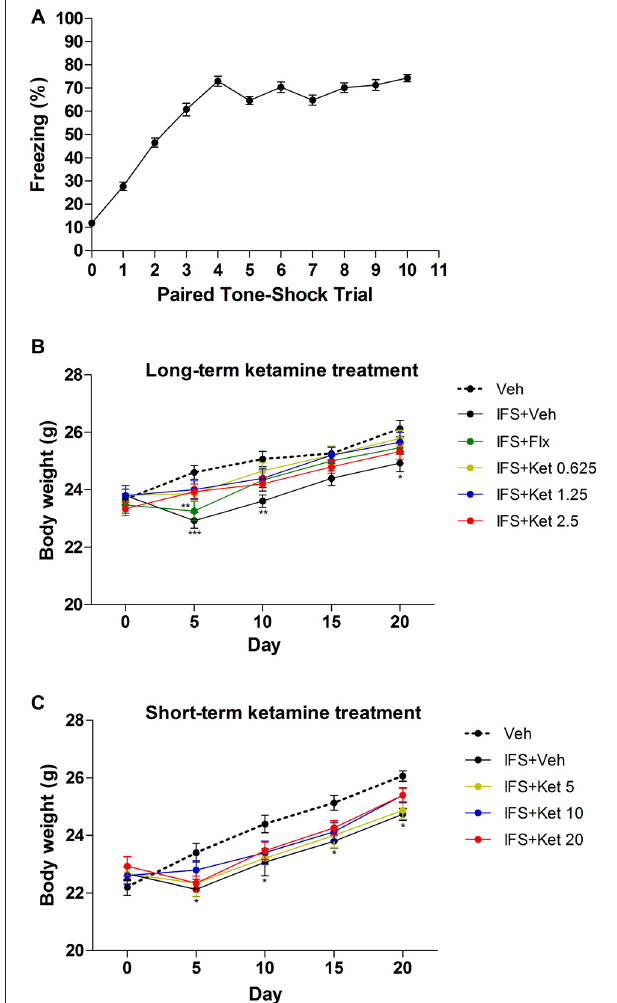
FIGURE 2 | The effects of ketamine treatment on body weight after electric foot shocks procedures. (A) Percentage of time freezing, in mice, to the conditioned tone (CS) following tone-shock pairings during the conditioned fear trials. (B,C) IFS mice had lower body weight compared with the Veh group, and both Flx and ketamine alleviated the loss of body weight induced by IFS. There was no different in body weight among the varying doses of ketamine groups. Data are presented as mean ± SEM ( n = 50 in A ; n = 15 in per group). ∗ P < 0.05, ∗∗ P < 0.01, ∗∗∗ P < 0.001 compared with the Veh